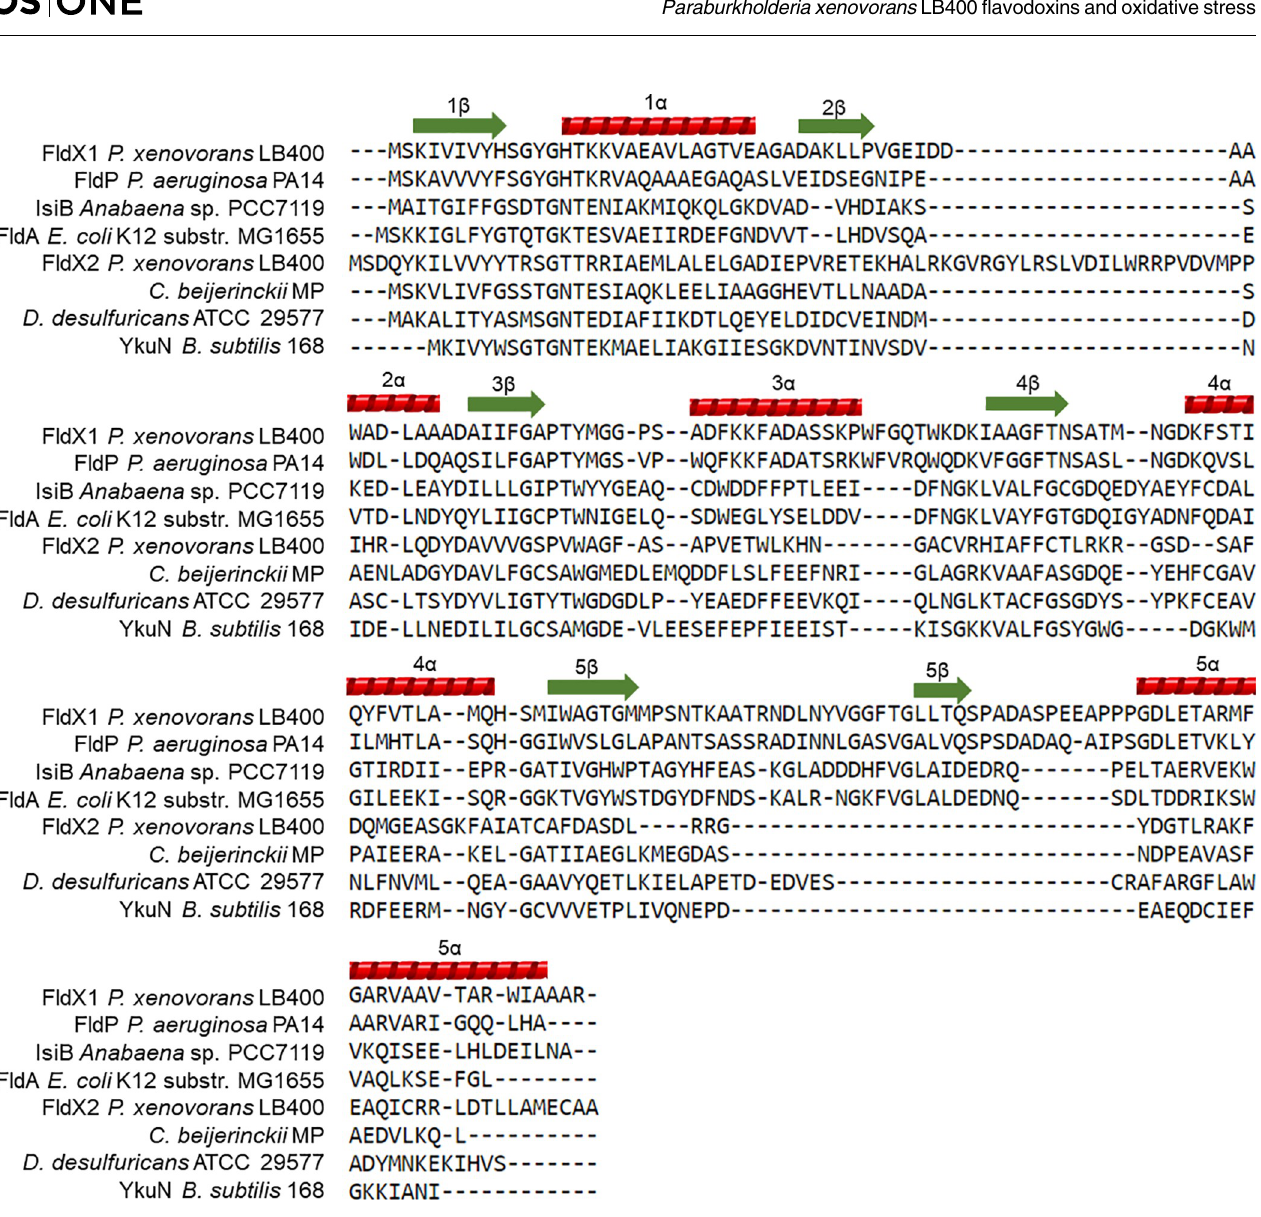
Fig 1. Prediction of secondary structure of LB400 flavodoxins. Green arrows indicates β -sheets and red helices indicates α -helices.